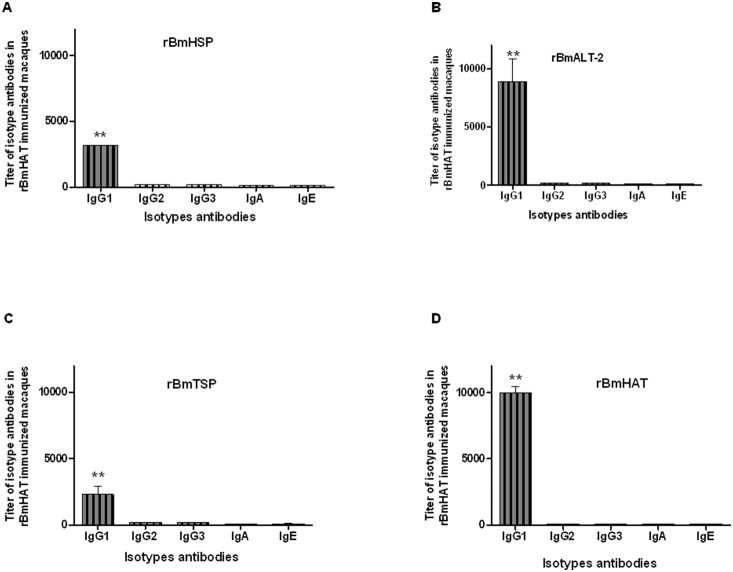
rBmHAT specific antibodies isotypes in the sera of macaques.Levels of IgG1, IgG2, IgG3, IgA and IgE antibodies against A) rBmHSP, B) rBmALT-2, C) rBmTSP and D) rBmHAT were determined in the sera (collected one month after the final dose of vaccine) of each rhesus macaque using an indirect ELISA. IgG1 antibodies were predominantly present in the immunized animals against all the four antigens tested. Each bar represents mean ±S.D of 5 animals. Significant **P<0.001 titer of antibodies observed compared to other animals.